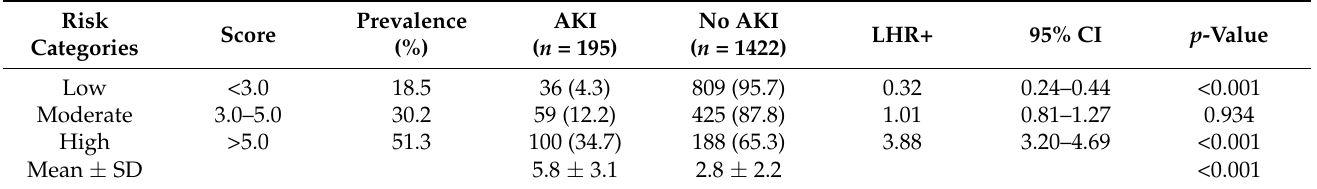
Table 3. Distribution of AKI, non-AKI, and likelihood ratio of AKI (LHR+) in low-, moderate-, and high-risk categories.